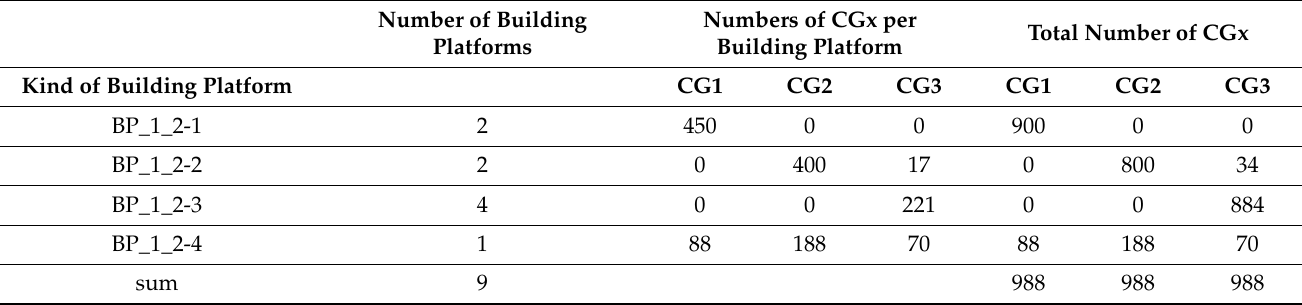
Table 4. Numbers of different types of cylinder geometries (CG) arranged on the different building platforms for problem 1–solution 2 with 988 components per type in nine printing jobs.